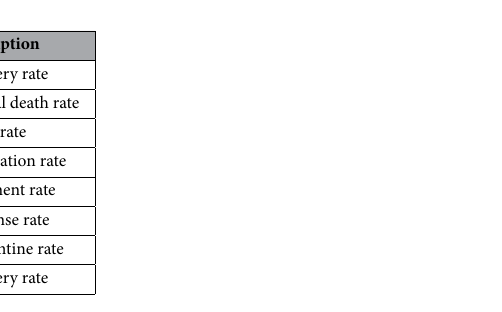
Table 1. Notations and description for variables and parameters for